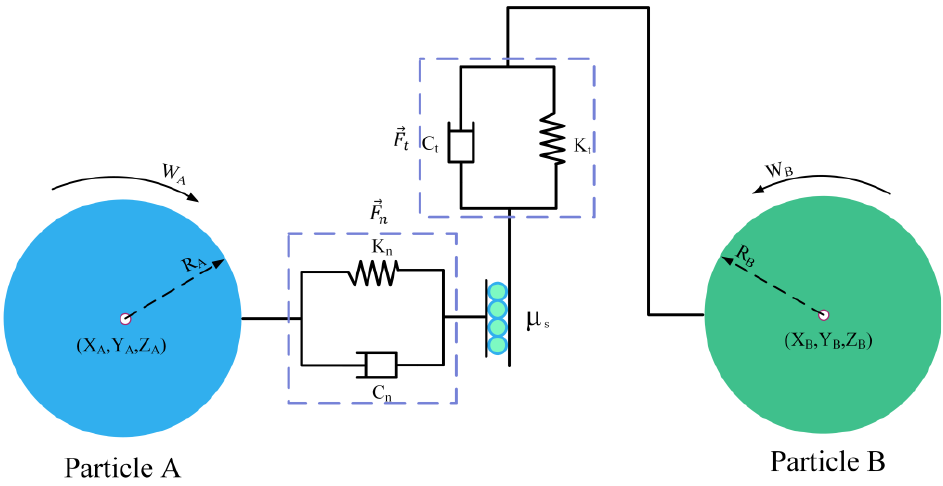
Figure 5. Contact mechanics model between the particles.